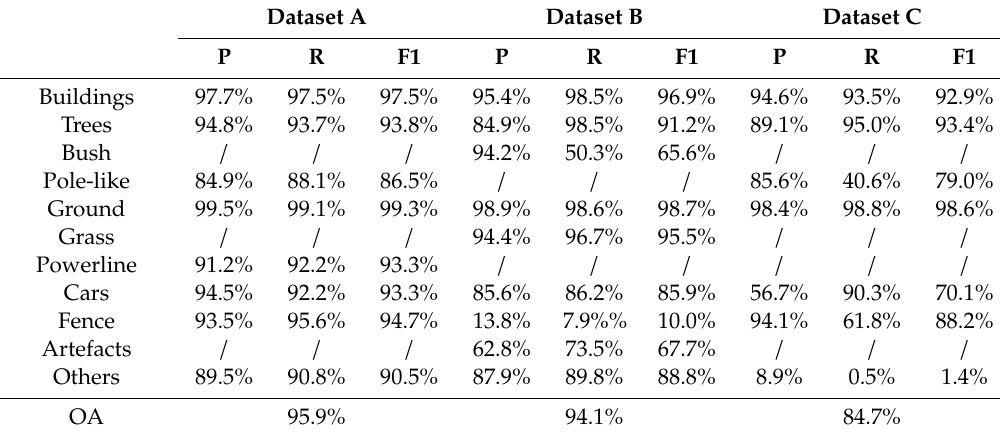
Table 3. Quantitative spatially smoothed results based on optimal neighborhood. (Precision (P), Recall (R), F 1 score (F1)).